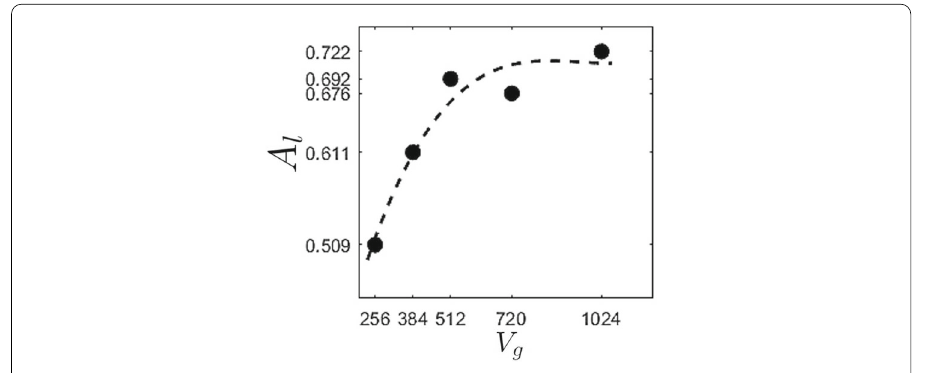
Fig. 13 Damage localization, case 1. Dependence on V g of the accuracy A l of the classifier G